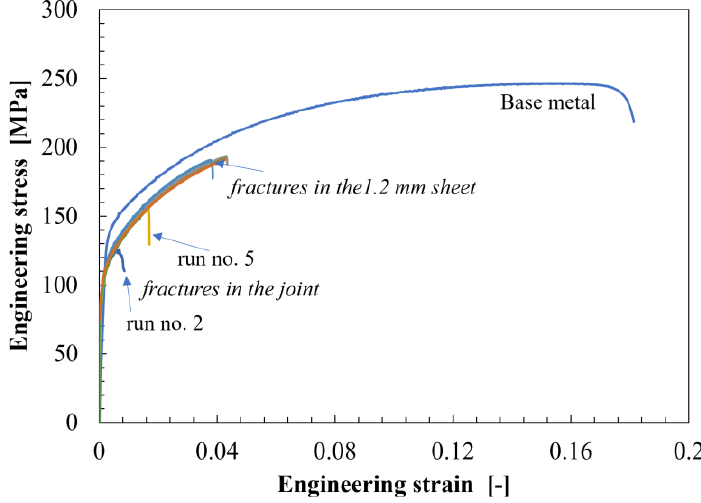
Figure 6. Engineering stress-strain curves for the 2 mm thick base metals and the welded joints.